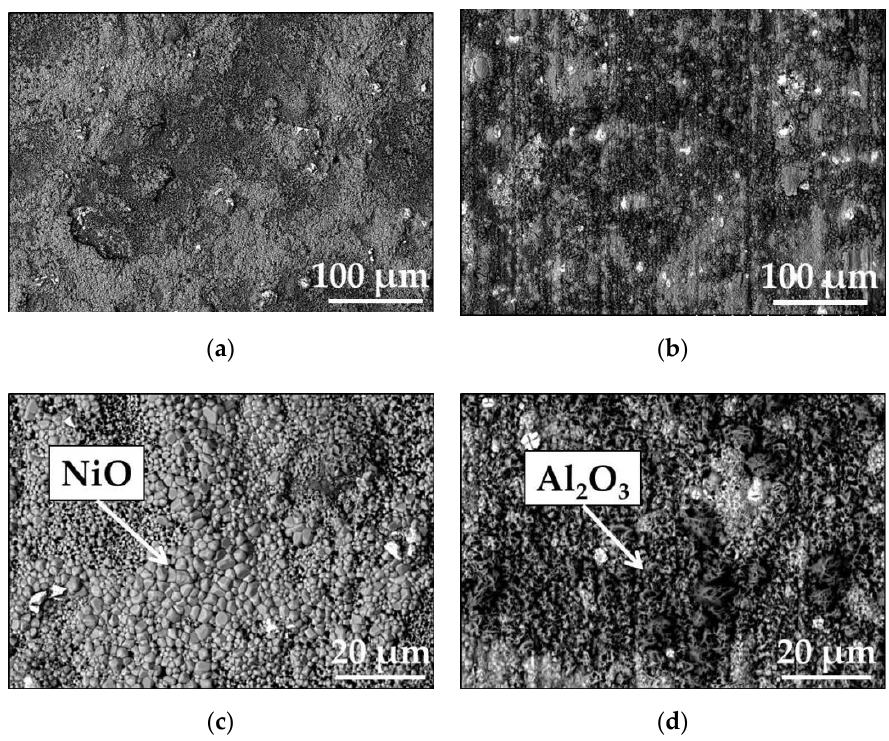
Figure 6. SEM/BSE images performed on surface of Mar M 247 after rapid cyclic oxidation test at 1000 °C after 360 cycles with: ( a ) polished up to 1 µ m diamond paste taken at low magnification ( a ) and high magnification ( c ); ( b ) Ground using 80 grit sand paper taken at low ( b ) and high magnification ( d ).